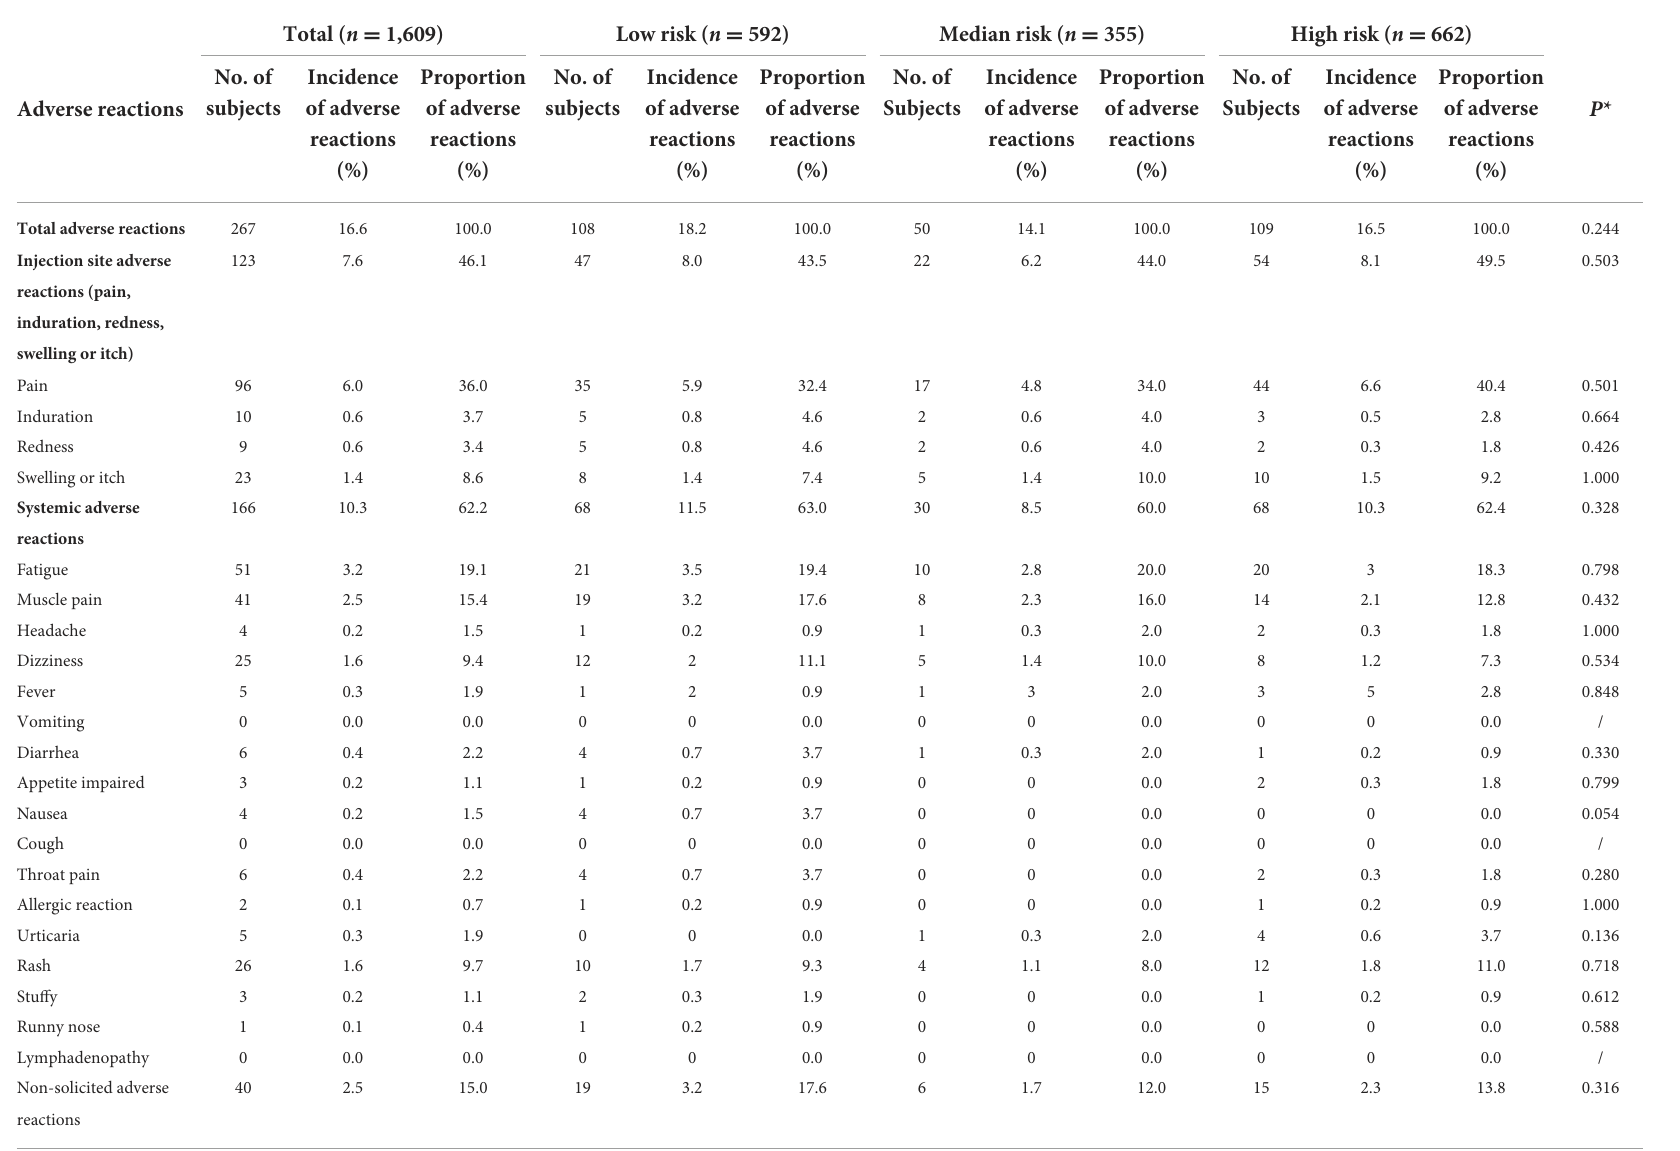
TABLE 2 Distribution of multiple types of adverse reactions after first